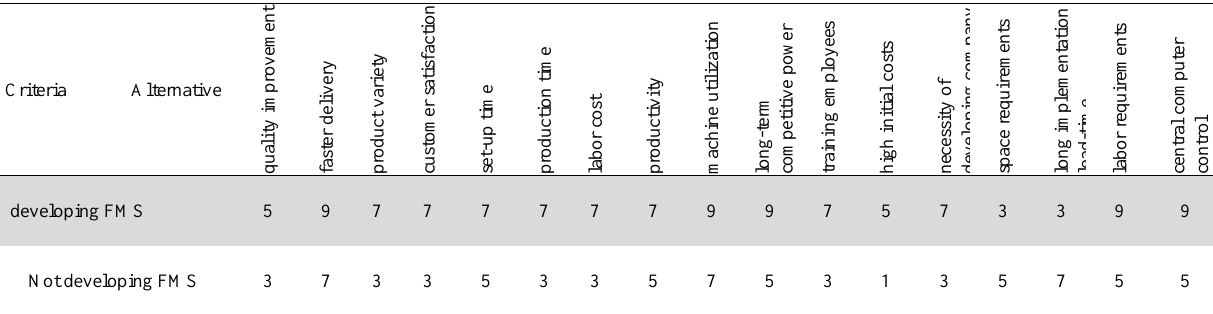
Decision matrix (collected data based on scale values 1-9)